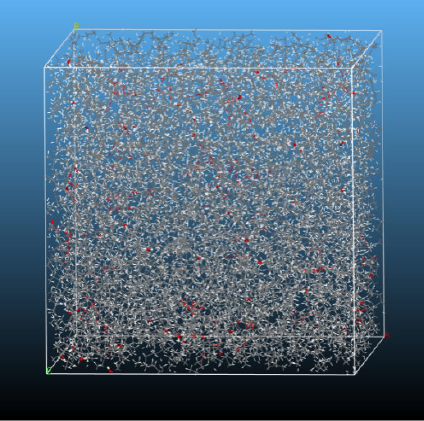
Figure 3. 30 wt% VO mixed oil model with 1wt% of water content.